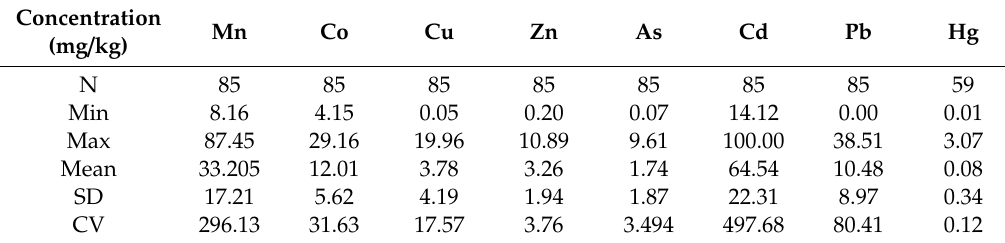
Table 2. Chemical availability of PTEs in soil (%).